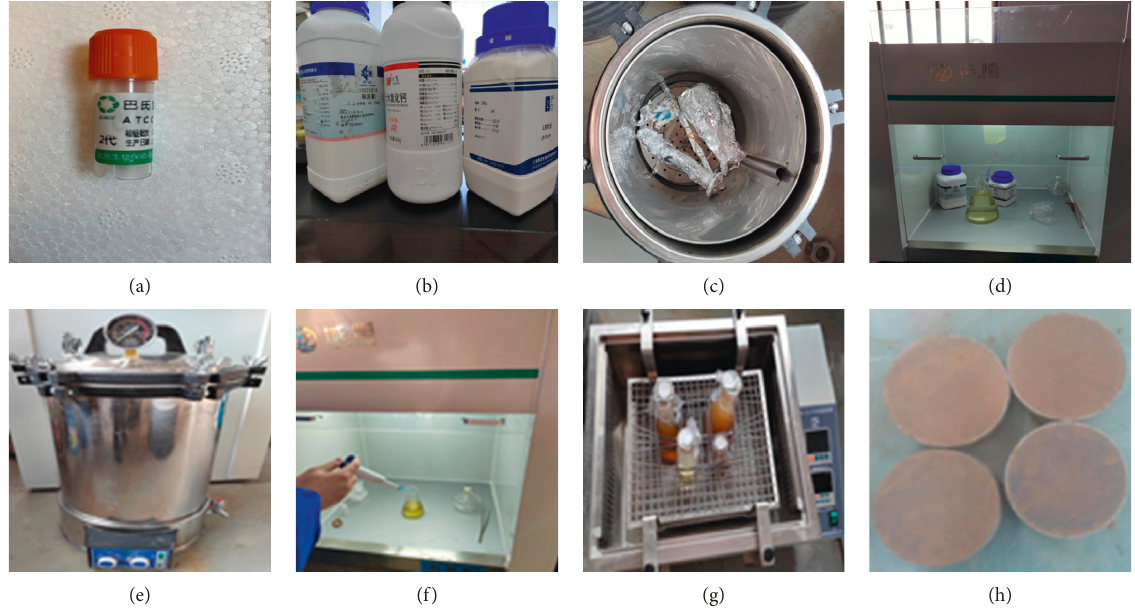
Figure 2: Test sample preparation process diagram. (a) Sporosarcina pasteurii sealed with glycerin. (b) LB broth and urea. (c) The in- strument sterilized in the autoclave. (d) LB broth dissolved in distilled water. (e) LB broth dissolved in distilled water and sterilized in an autoclave. (f) Sporosarcina pasteurii sealed with glycerol was inoculated into the culture medium. (g) Expanding culture Sporosarcina pasteurii in a constant temperature vibration incubator. (h) The loess samples treated by MICP in an annular 61.8mm × 20 mm metal Figure 4. At a pressure of 100 kPa, the microbial cementation